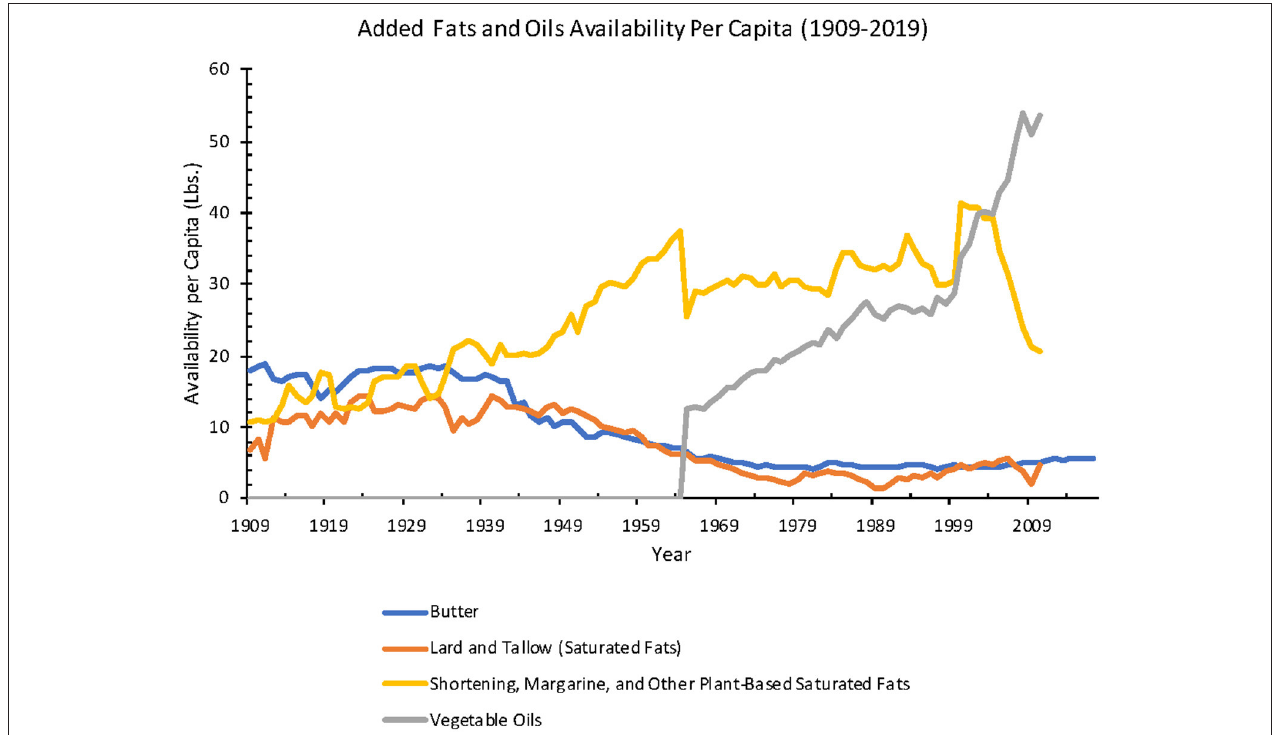
FIGURE 5 | Annual added fats and oils availability per capita from 1909 to 2019 (Source: USDA ERS ).